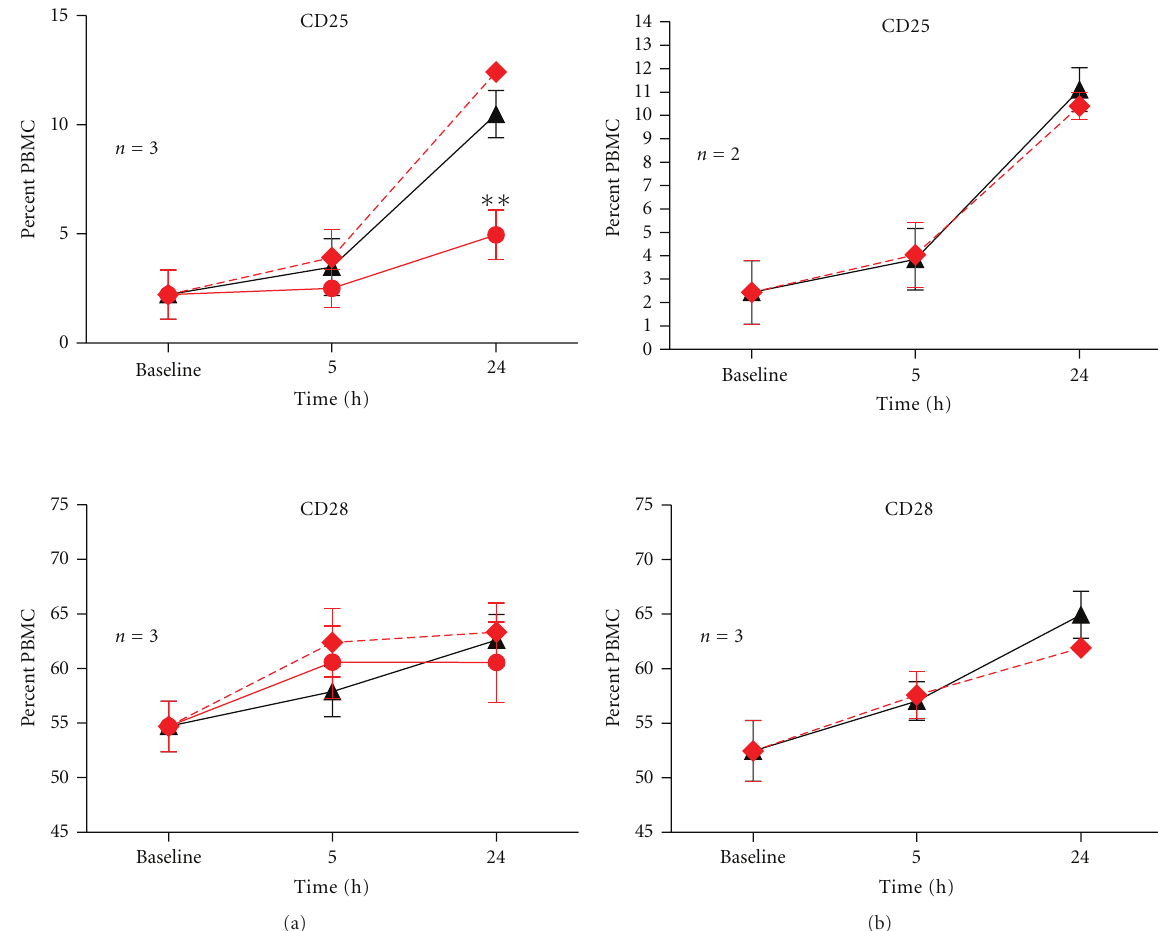
Figure 3: Modulation of CD25 and CD28 on αβ T cells by IPP-activated γδ T cells. PBMCs were cultured overnight in the presence of IPP or absence of IPP before stimulation with 1nM of TSST-1 (a). Data (mean ± SEM) for expression of CD25 and CD28 were shown after various time intervals following TSST-1 stimulation, and the numbers of healthy donors studied for each coreceptor were as indicated. Baseline values were obtained from PBMC treated with RPMI growth medium alone. To determine the influence of IPP-activated γδ T cells on receptor expression, comparisons were made between IPP + TSST-1 (dashed red lines) versus TSST-1 alone (solid black line) and significant di ff erences were denoted by ( ∗ ). To confirm that any observed di ff erence in receptor expression was due to the presence of activated γδ T cells, a cognate group of PBMCs was depleted of γδ T cells ( < 0.1%) and studied in parallel experiments (b). To determine the influence of TSST-1 on IPP-activated γδ T cells, comparisons were made between IPP + TSST-1 versus IPP alone, and significant di ff erences were denoted by ( ∗∗ ). There was no additional e ff ect of IPP-activated γδ T cells on CD25 and CD28 expression following TSST-1 stimulation; however, CD25 expression on αβ T cells following TSST-1 stimulation in the presence of IPP-activated γδ T cell was significantly higher at 24 hour than with IPP alone ( ∗∗ P = . 001, student’s t